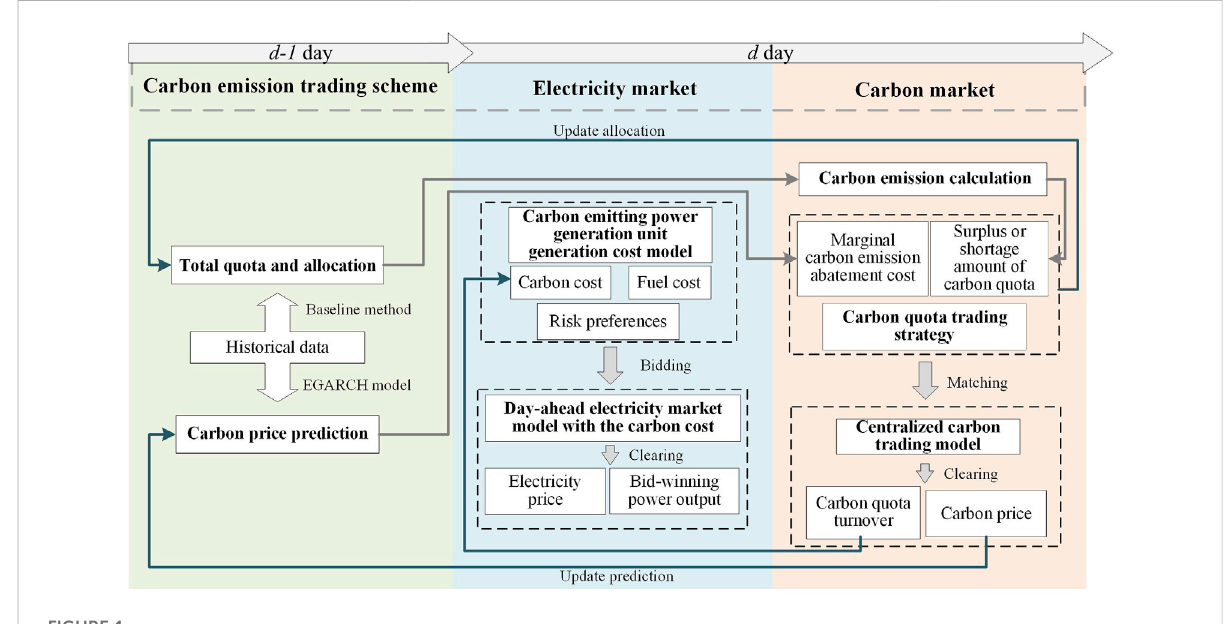
FIGURE 1 Coordinated trading process in the carbon and electricity